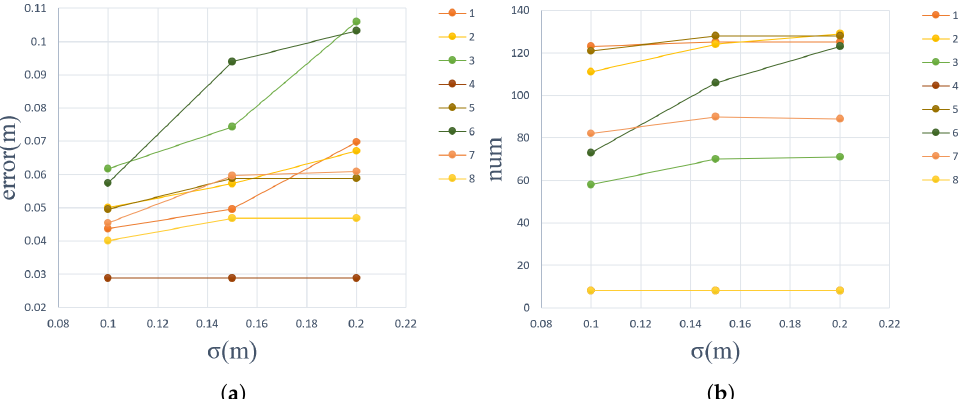
Figure 14. The influence of the choice of σ on the fitting effect. ( a ) the average fitting error of a single wire under different σ ; ( b ) the number of points fitted by a single wire under different σ (1–8 represent 8 wires in a span